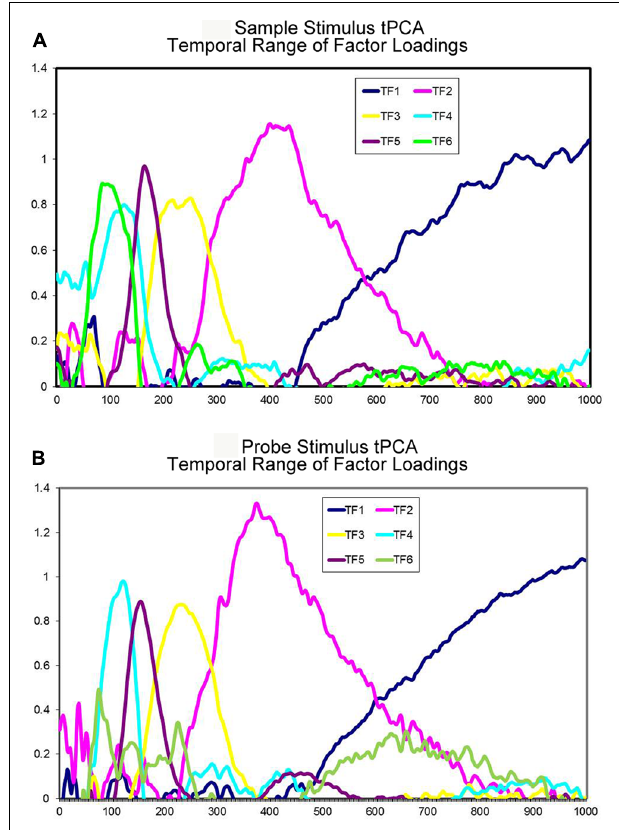
FIGURE 2 |Temporal principal components analysis extracted factors. (A) Time course of the different temporal factors extracted in the tPCA with sample stimulus related data. (B) Time course of the different temporal factors extracted in the tPCA with probe stimulus related